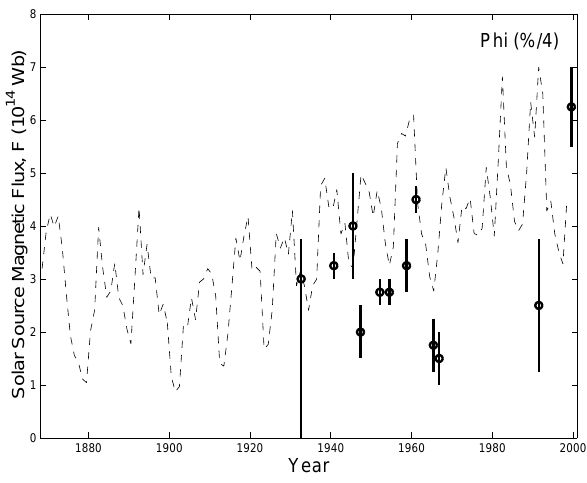
Fig. 1. Uncorrected 8 values (circles, with uncertainties given by the vertical bars) calculated from ionospheric measurements for 12 eclipses between 1932 and 1999. For comparison, the solar source magnetic flux (dashed line) estimated from the aa geomagnetic in- dex is shown as a dashed